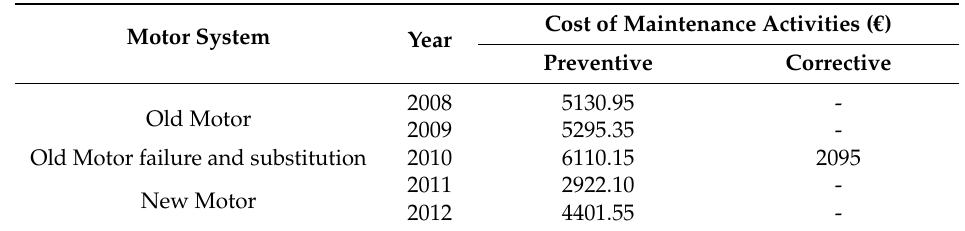
Table 3. Estimated maintenance activities